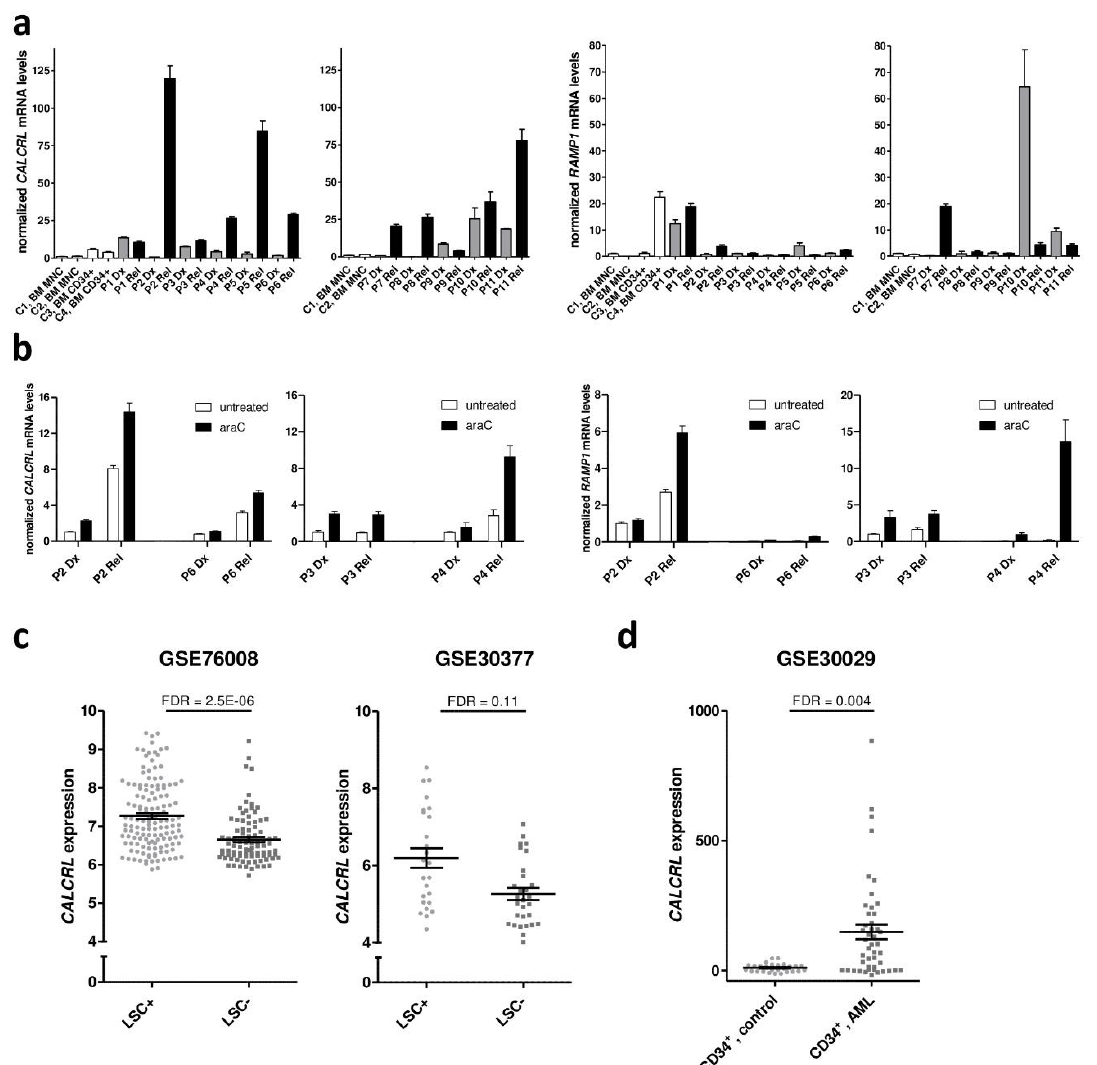
Figure 1. CALCRL expression is elevated at relapse of AML and in leukemic stem cells, and induced by araC. ( a ) Expression of CALCRL and RAMP1 in paired samples from diagnosis (Dx) and relapse (Rel) of AML was determined by qRT-PCR. Normalization to β -2-microglobulin and calibration to sample C1 was performed using the ∆∆ C T method. C1–C4, healthy control samples 1–4; BM, bone marrow; MNC, mononuclear cells; P1–P11, patients 1–11. Means + SD from technical replicates. ( b ) Expression of CALCRL and RAMP1 in paired samples from diagnosis (Dx) and relapse (Rel), cultured in the presence or absence of araC for 2 days, was measured as in ( a ). ( c ) Expression of CALCRL in stem cell enriched (LSC + ) versus stem cell depleted (LSC–) leukemic cell populations contained in data sets GSE76008 and GSE30377. ( d ) Expression of CALCRL in CD34 + cell populations from AML versus healthy donors, contained in data set GSE30029. ( c , d ) Data were used as provided in the respective data sets (log2 transformed or not). False discovery rate (FDR) was determined using the lmFit function of the R package Limma.